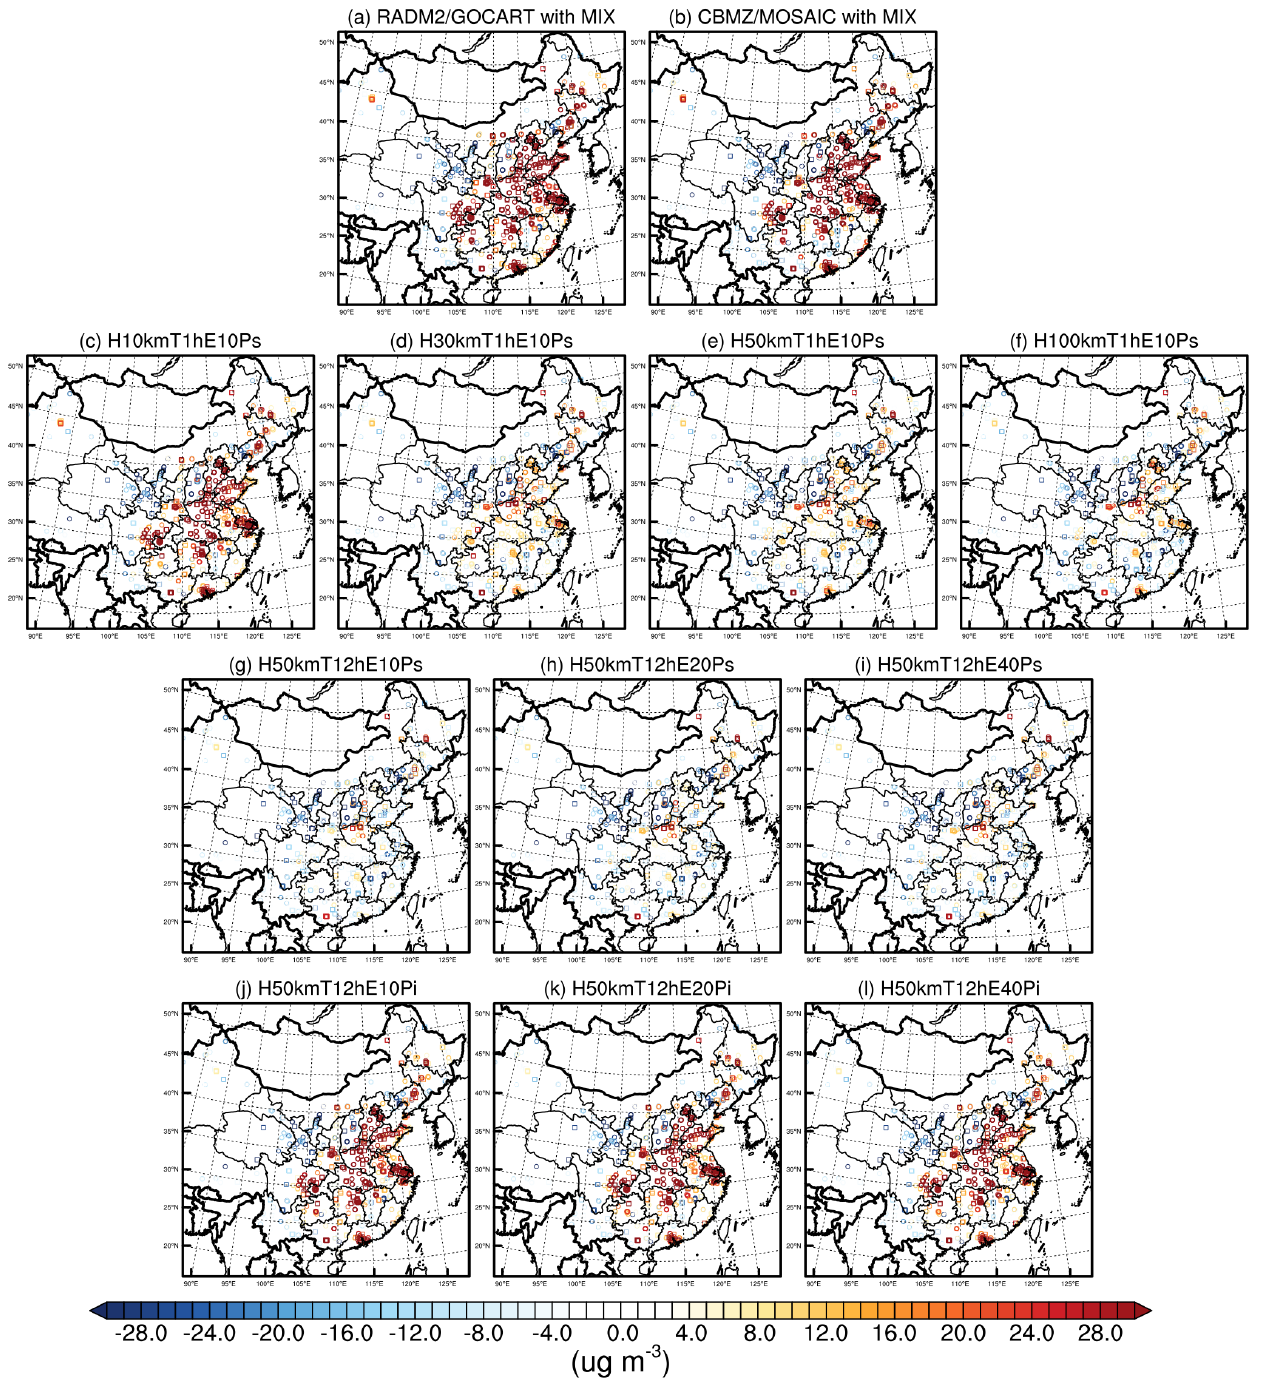
Figure 6. Spatial distributions of the mean biases between the simulated surface SO 2 concentrations in various experiments and the CNEMC- observed ones over both the assimilated and independent sites. The locations of the assimilated and independent verification observation sites of the CNEMC are shown by the circles and squares,